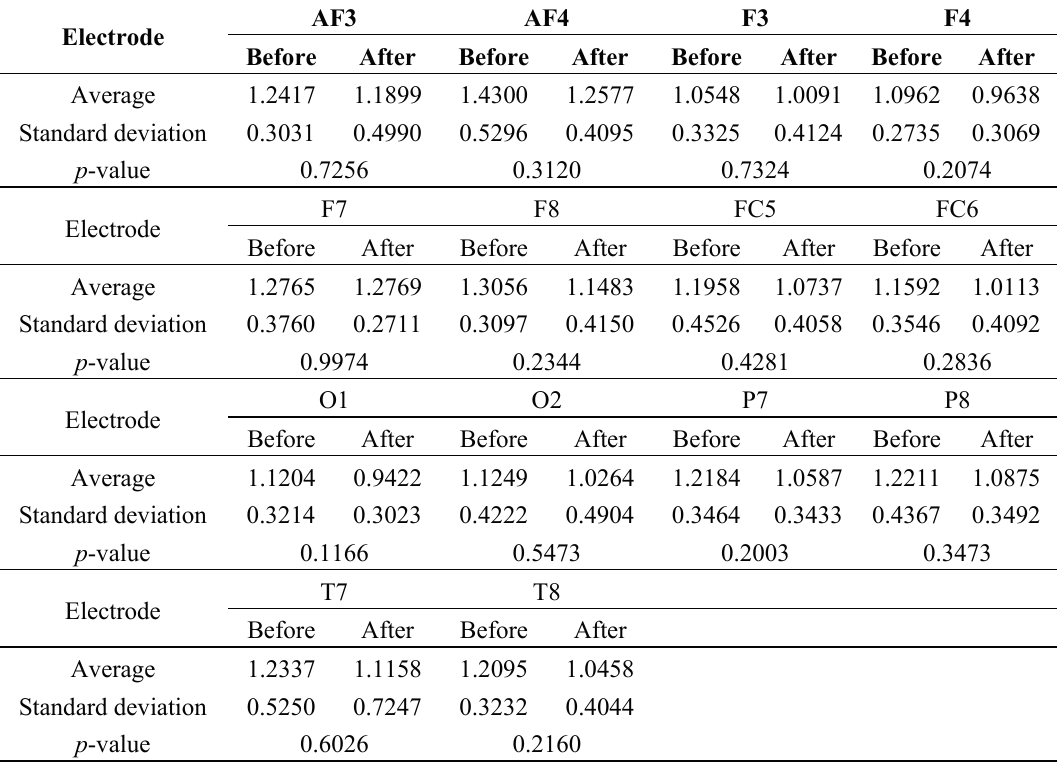
Figure 16. Ratios of delta band to beta band of EEG data before and after watching the horror movie. Table 7. Average, standard deviation and p -value of the EEG signal for all